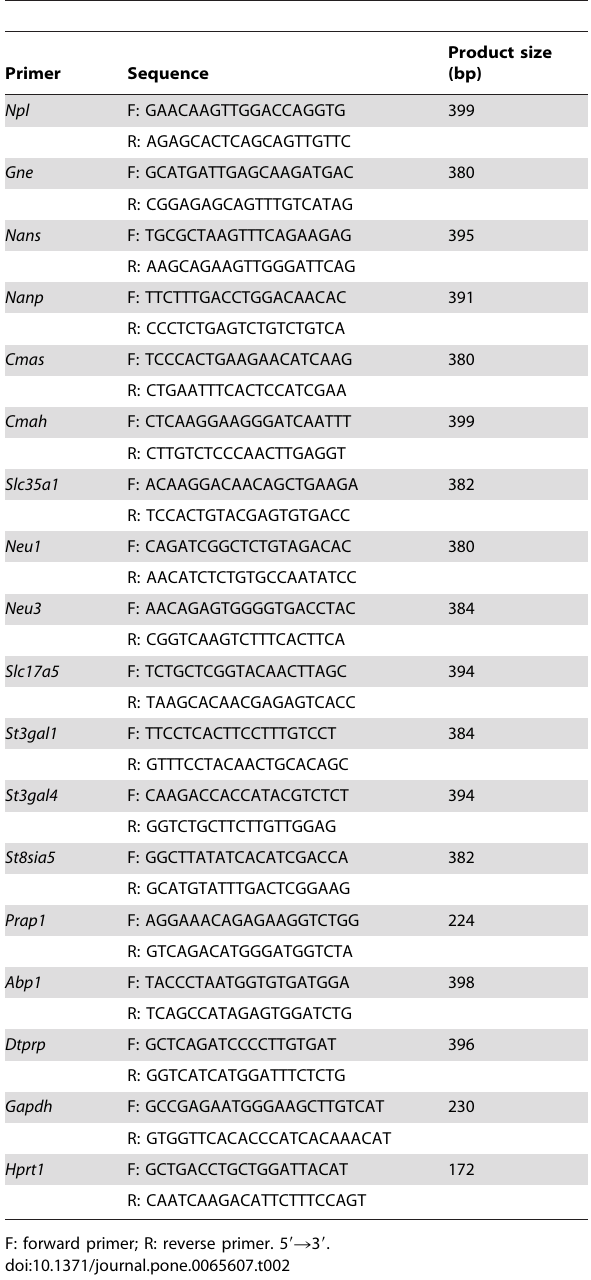
Table 2. Primers used for realtime PCR, making probes for in situ hybridization.